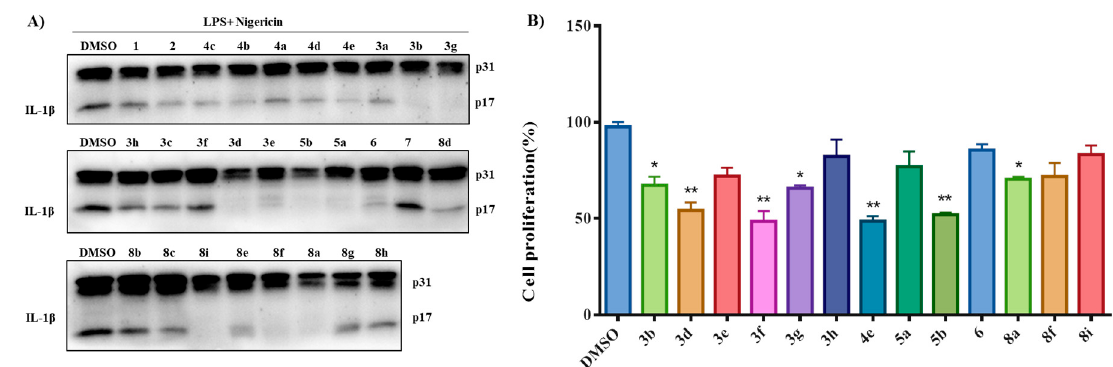
Figure 2. (A ) Immunoblot analysis of IL-1 β in culture supernatants of PMA primed THP-1 cells treated with target compounds (5 μ M) and then stimulated with lps and nigericin; ( B ) Cellular proliferation assays of key compounds (5 μ M) in THP-1 for 24 h by MTT assay. Table 1. Structures and inhibition effects of target compounds on IL-1 β release activities.